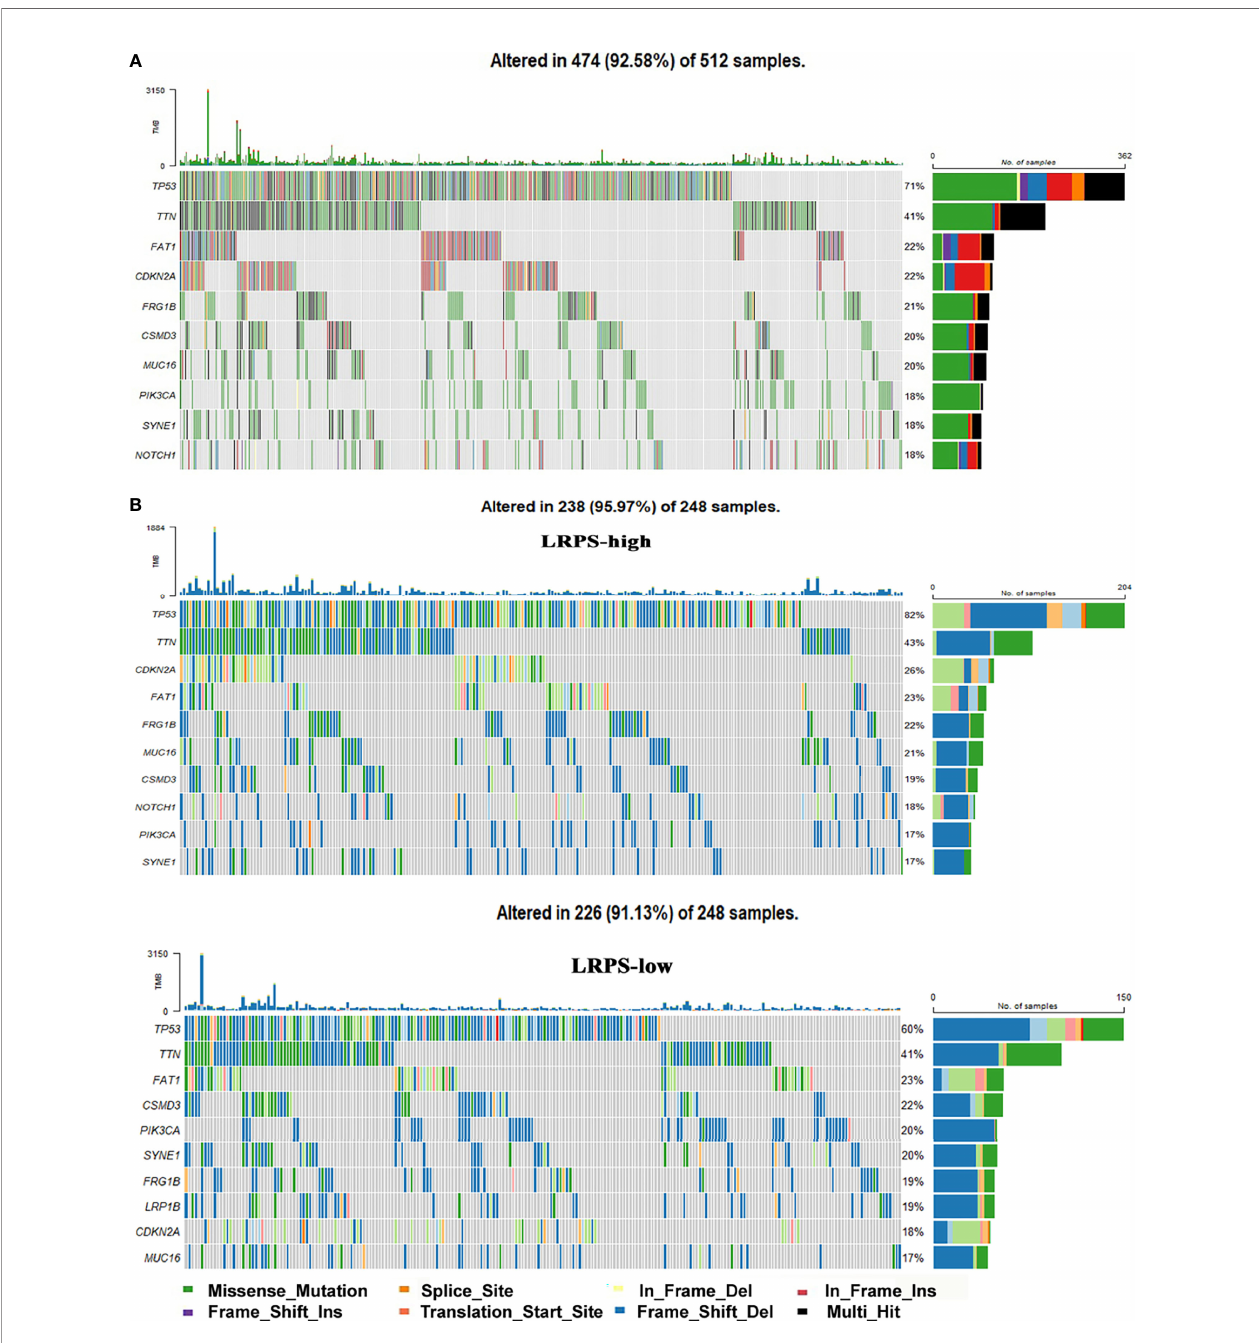
FIGURE 8 | Genomic mutations in the LRPS. (A) Genomic mutation signature in the patients with HNSCC from the TCGA database. (B) Signi fi cantly mutated genes in LRPS-high and LRPS-low subgroups. The top 10 mutated genes are listed; the right shows mutation percentage and the top shows the overall mutation rates of different